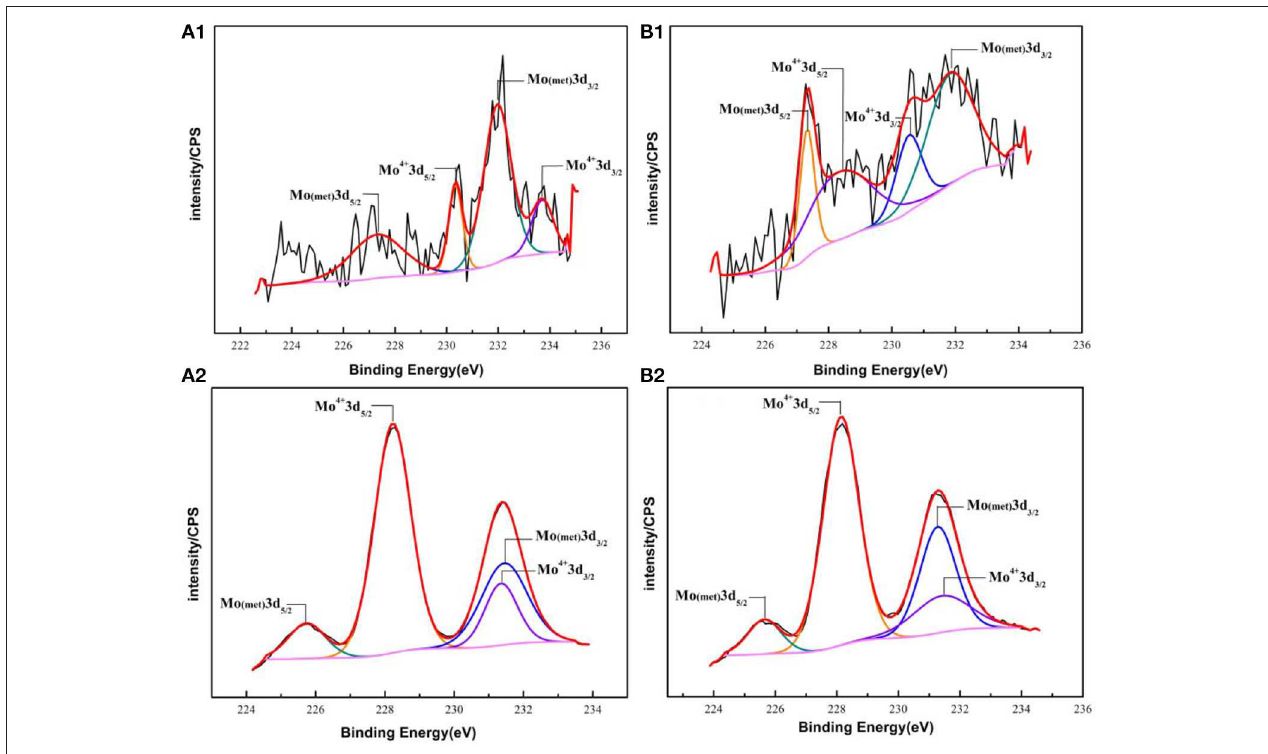
FIGURE 9 | Experimental and fitted narrow XPS spectra of Mo 3d of the surface film of (A1,B1) Bare and pre-passivated sample before exposure; (A2,B2) Bare and pre-passivated sample after 5 year exposure.